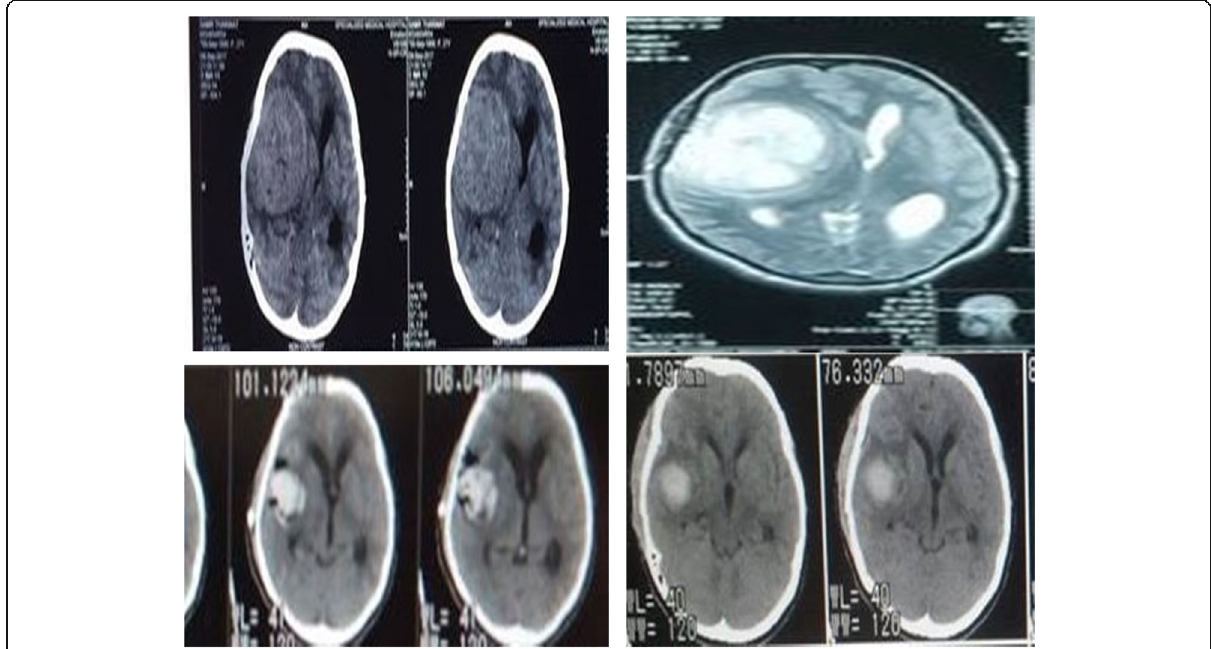
Fig. 2 Right-sided pterional giant meningioma. Upper left, axial CT brain without contrast show isointense meningioma with midline shift. Upper right, axial T2 MRI of the same lesion with midline shift. Lower left, early postoperative CT brain showing hematoma in the tumor bed. Lower right, 2 weeks later postoperative CT brain with resolution of hematoma